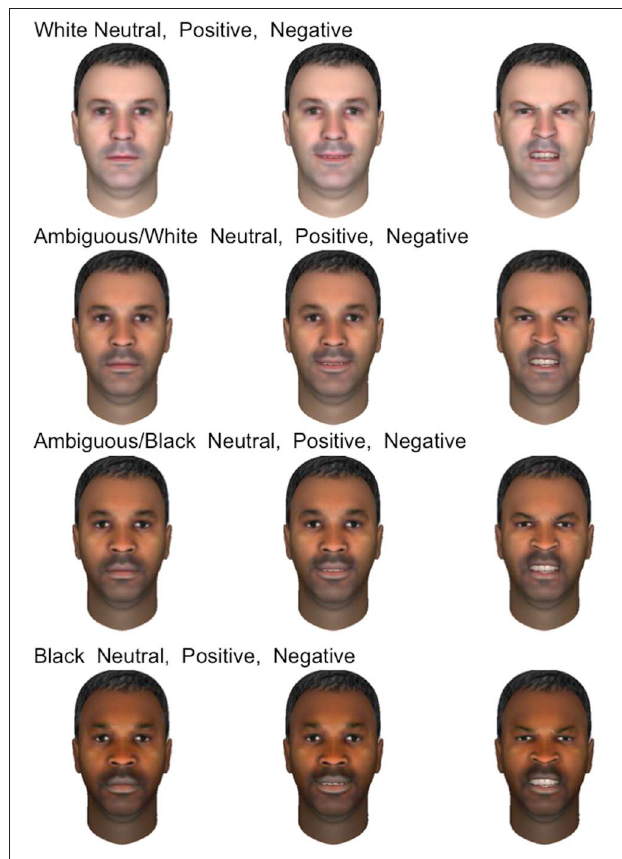
FIGURE 1 | Examples of emotional stimuli presented to subjects. The faces shown are generated from a single prototype face image and depict four races, from top to bottom rows: white, ambiguous white, ambiguous black, and black. In each row, three emotional expressions are shown: neutral, positive, and